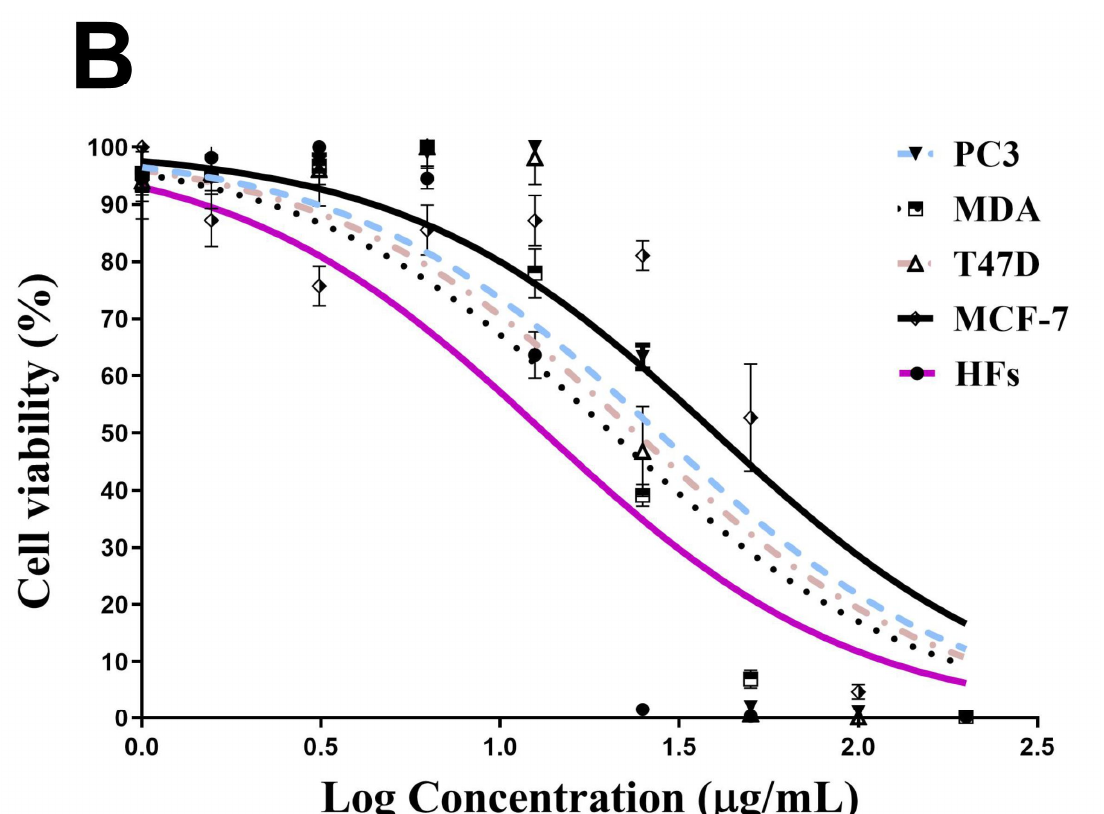
Figure 10. Antiproliferative activity ( A , B ) of a twofold serial dilution of 200 µ g/mL of Uv@Ag-NPs synthesised from the unicellular ulvophyte sp. MBIC10591 against four malignant cells, PC3, MDA-MB-231, T47D, and MCF-7, and normal cells, HFs. Data are represented as mean ± SEM. p -values were calculated versus untreated cells: **** p < 0.0001, ** p < 0.001, and * p < 0.01.